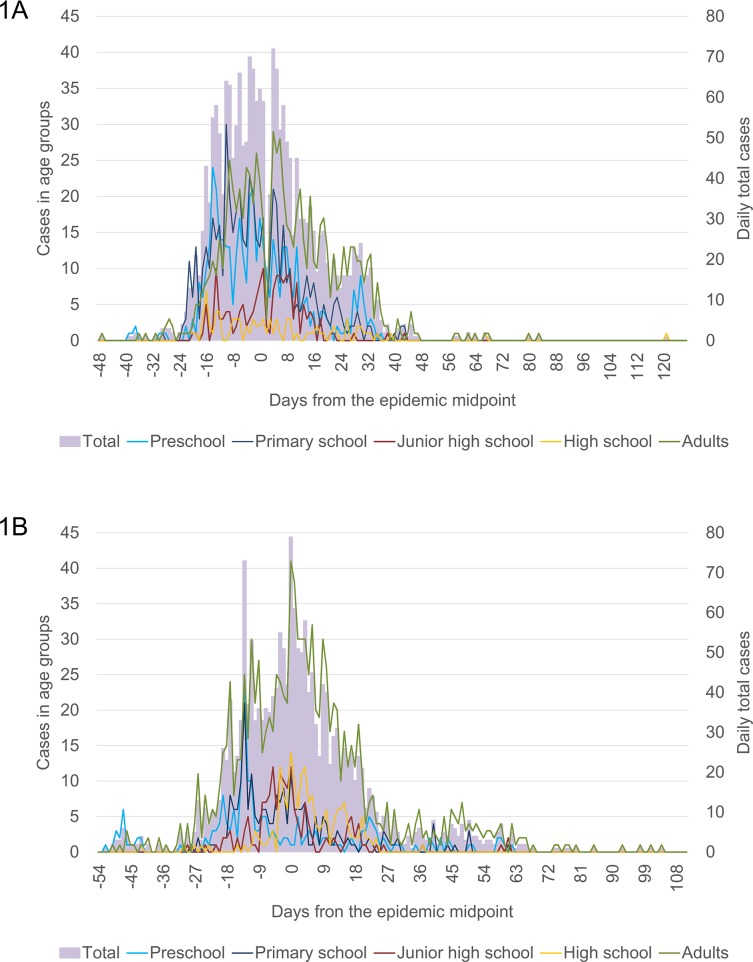
Daily number of Influenza A positive cases by age group in 2011/12 (1A) and 2012/13 (1B) seasons in Odate City, Akita, Japan.* The day of epidemic midpoint was set as Day 0. Those dates were February 8, 2012 and February 2, 2013, respectively.